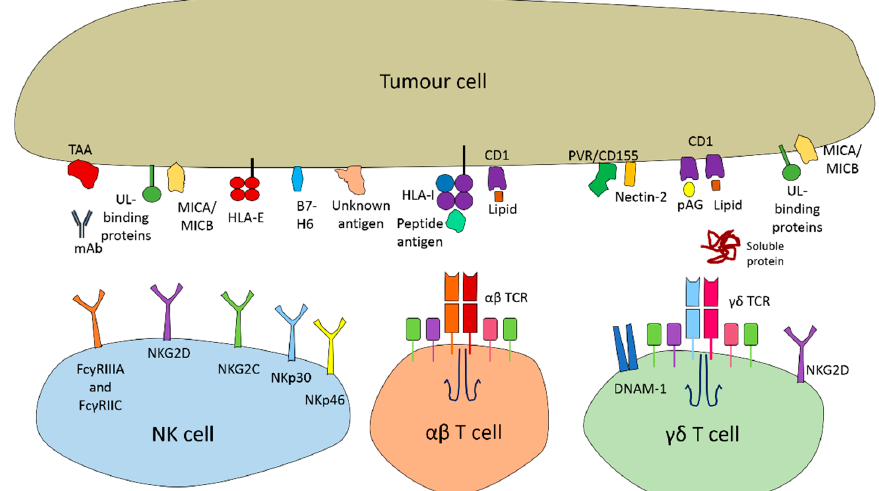
Figure 1. Diagram illustrating some of the main receptors present on NK cells, αβ T cells and γδ T cells and their corresponding ligands that are involved in tumour cell recognition and killing. NK cells express a variety of receptors that allow them to recognize tumour cells, the FcyR receptors recognised the constant region of antibodies what bind to TAA’s on tumour cells. NKG2D expressed on both NK cells and γδ T cells, has a variety of ligands, including UL16-binding proteins and MICA/B. NKG2C recognizes HLA-E expressed on tumour cells. NKp30 can bind B7-H6 and NKp46 mediates tumour directed killing via an unknown ligand. αβ T cells express a αβ TCR which recognises peptide antigens that are sampled from inside the tumour and presented on HLA-I molecules. Both αβ and γδ TCRs can also recognise lipid antigens expressed on CD1. Additionally, γδ T cells also express DNAM-1 which recognises PVR/CD155 and Nectin-2. Unlike the αβ TCR, the γδ TCR can recognise soluble protein and is not restricted to recognizing antigen presented on HLA.